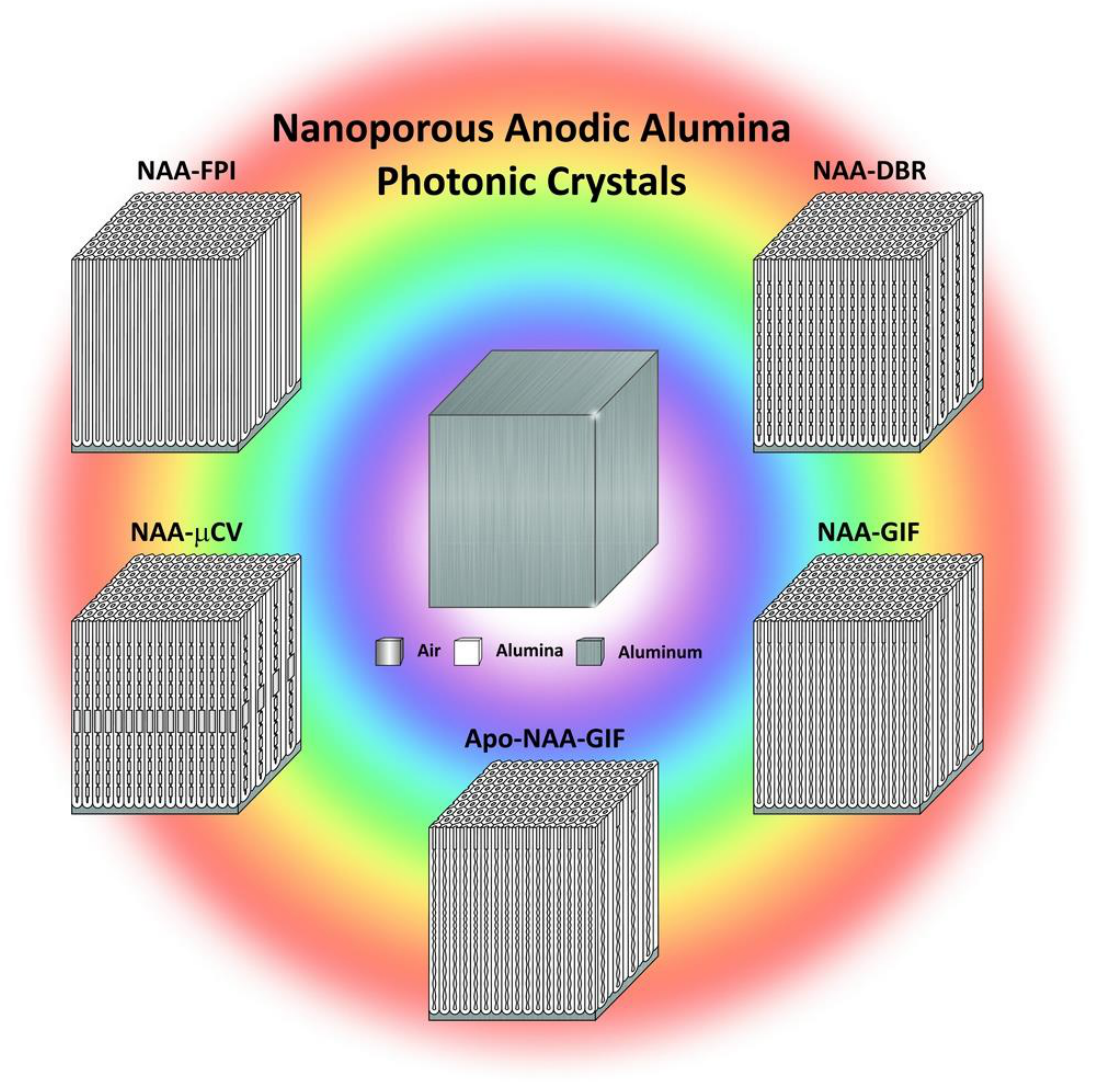
Figure 1. Nanoporous anodic alumina photonic crystals as effective medium platforms to control light–matter interactions for chemo- and biosensing applications. Schemes of representative NAA-PC structures: NAA-FPI—Fabry–Pérot interferometer; NAA-μCV—optical microcavity; NAA-APO-GIF—apodized gradient index filter; NAA-GIF—gradient index filter; NAA-DBR—distributed Bragg reflector.